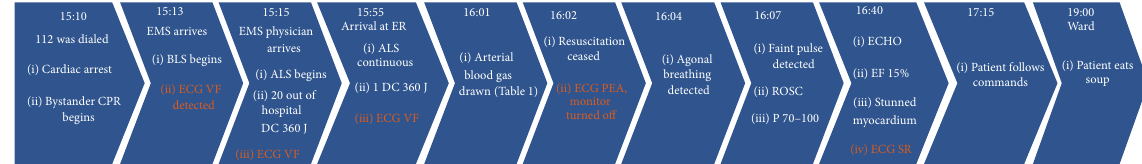
Figure 1: Timeline. CPR: cardiopulmonary resuscitation. EMS: emergency medical services. BLS: basal life support. ECG: electrocardiogram. VF: ventricular fibrillation. ALS: advanced life support. DC: direct current. ER: emergency room. PEA: pulseless electrical activity. ROSC: return of spontaneous circulation. ECHO: echocardiography. SR: sinus rhythm.